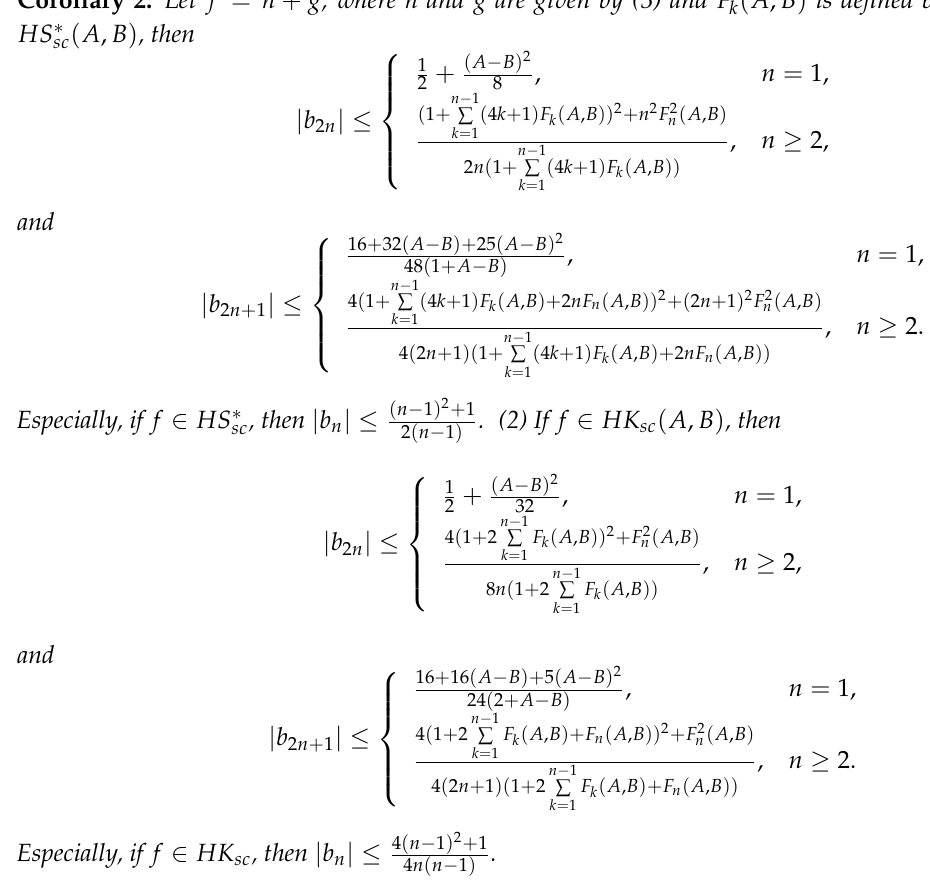
Figure 2. Three dimensional coordinates plus color, the z-axis represents the real part of the function, and the color represents the imaginary part of the function. ( a ) The graph of f 0 1 ( z ) 2 f 1